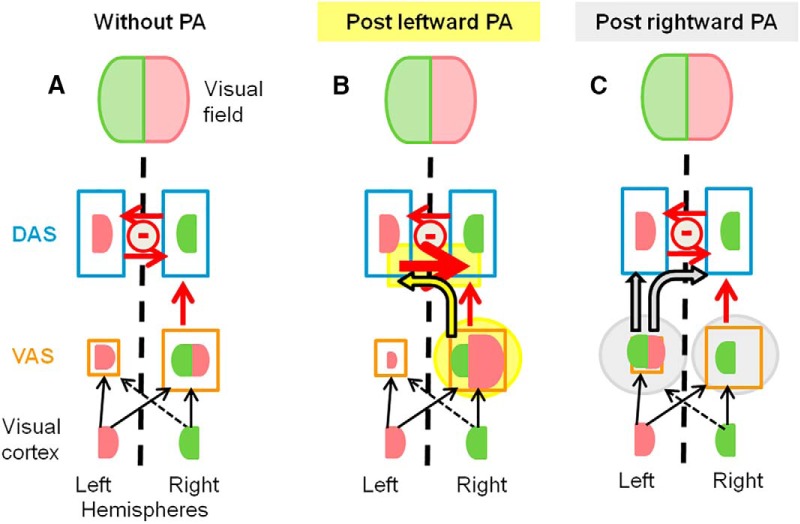
Schematic representation of the dorsal and ventral attentional systems (DAS, VAS, outlined in blue and orange, respectively), the visual areas, and their interactions (based on Koch et al., 2008; Corbetta and Shulman, 2011). Situations without PA (A) as well as after L-PA (B) and R-PA (C) are represented. L-PA-induced changes are highlighted in yellow: enhancement of right visual field representation in the right VAS (as reported in our current findings) and the increased inhibition from left to right DAS (resulting from change in respective excitability as in Schintu et al., 2016). R-PA-induced changes (C) are highlighted in gray (based on Crottaz-Herbette et al., 2014 and discussed in Clarke and Crottaz-Herbette, 2016).